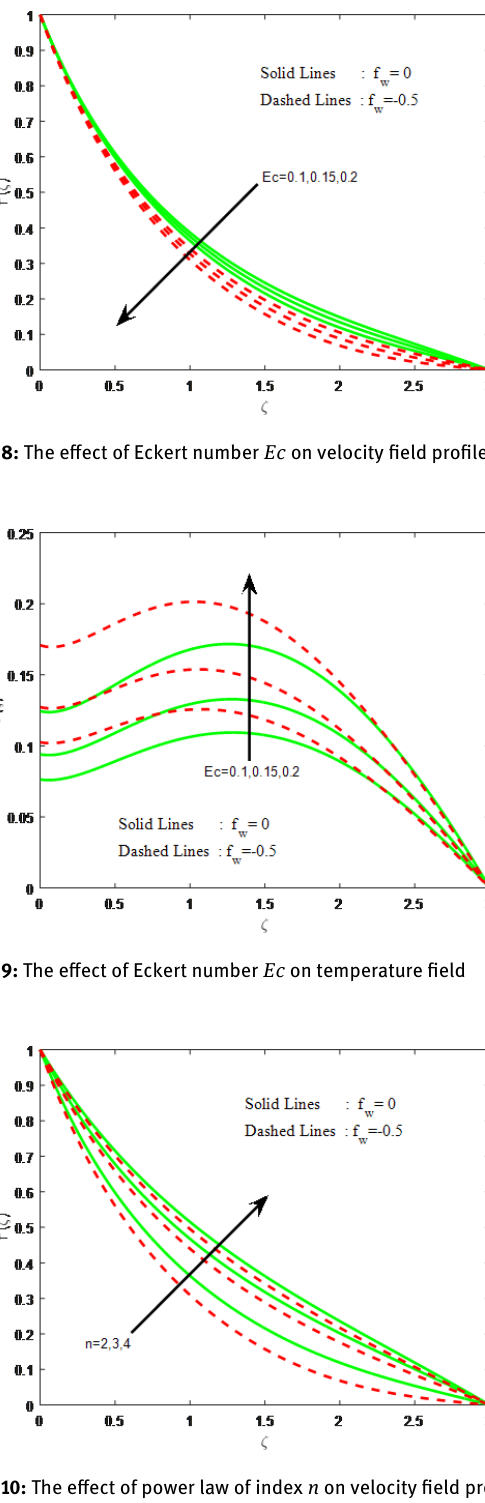
Fig. 10: The effect of power law of index n on velocity field profile